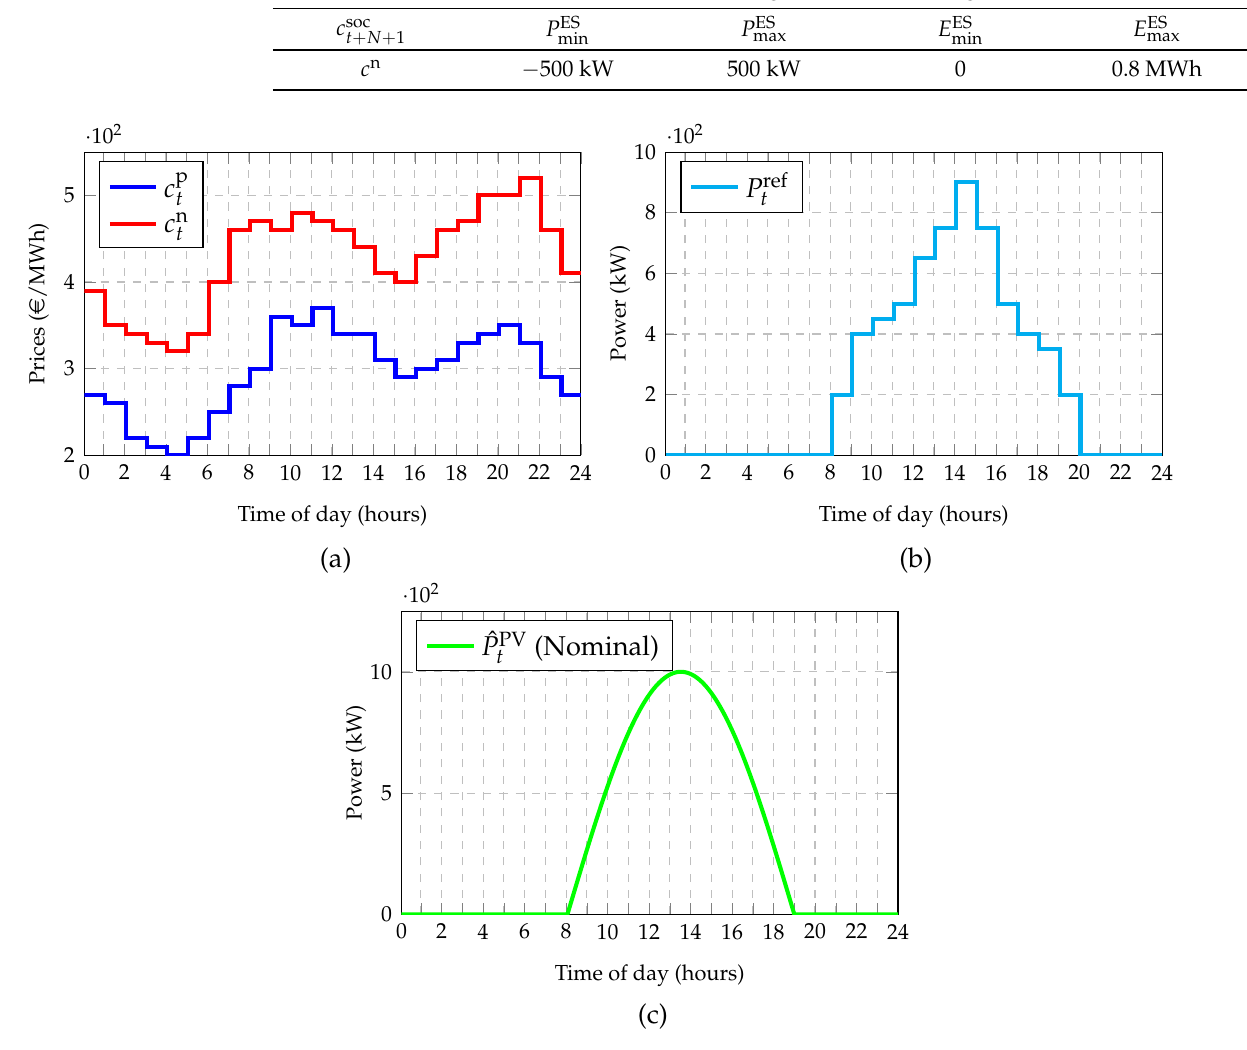
Figure 2. ( a ) Synthetic energy prices resembling the ones reported in [6]; ( b ) committed power per hour; and ( c ) power production of photovoltaic panels considering ideal solar